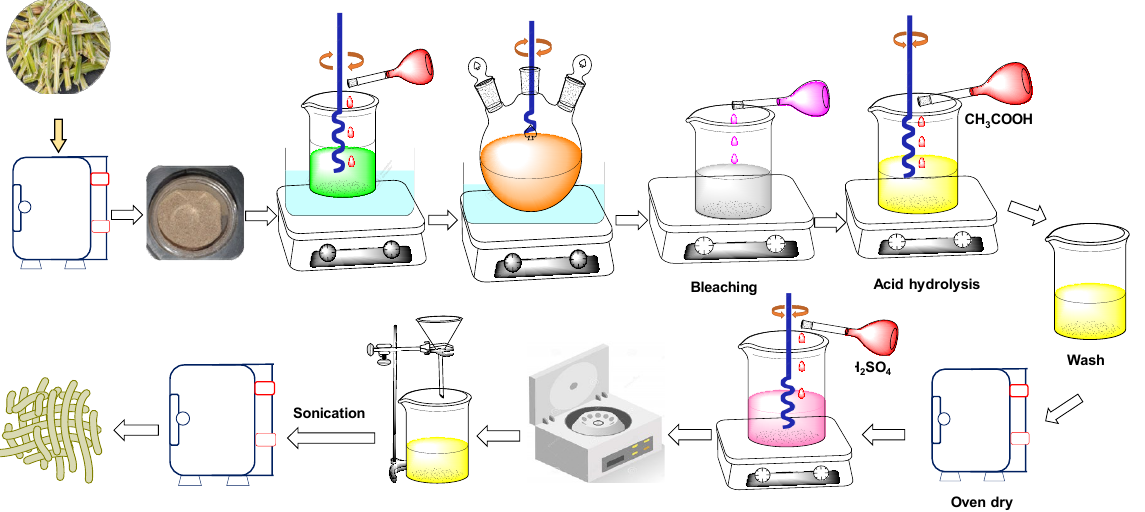
Figure 2. Preparation of cellulose-SCB particles from SCB.